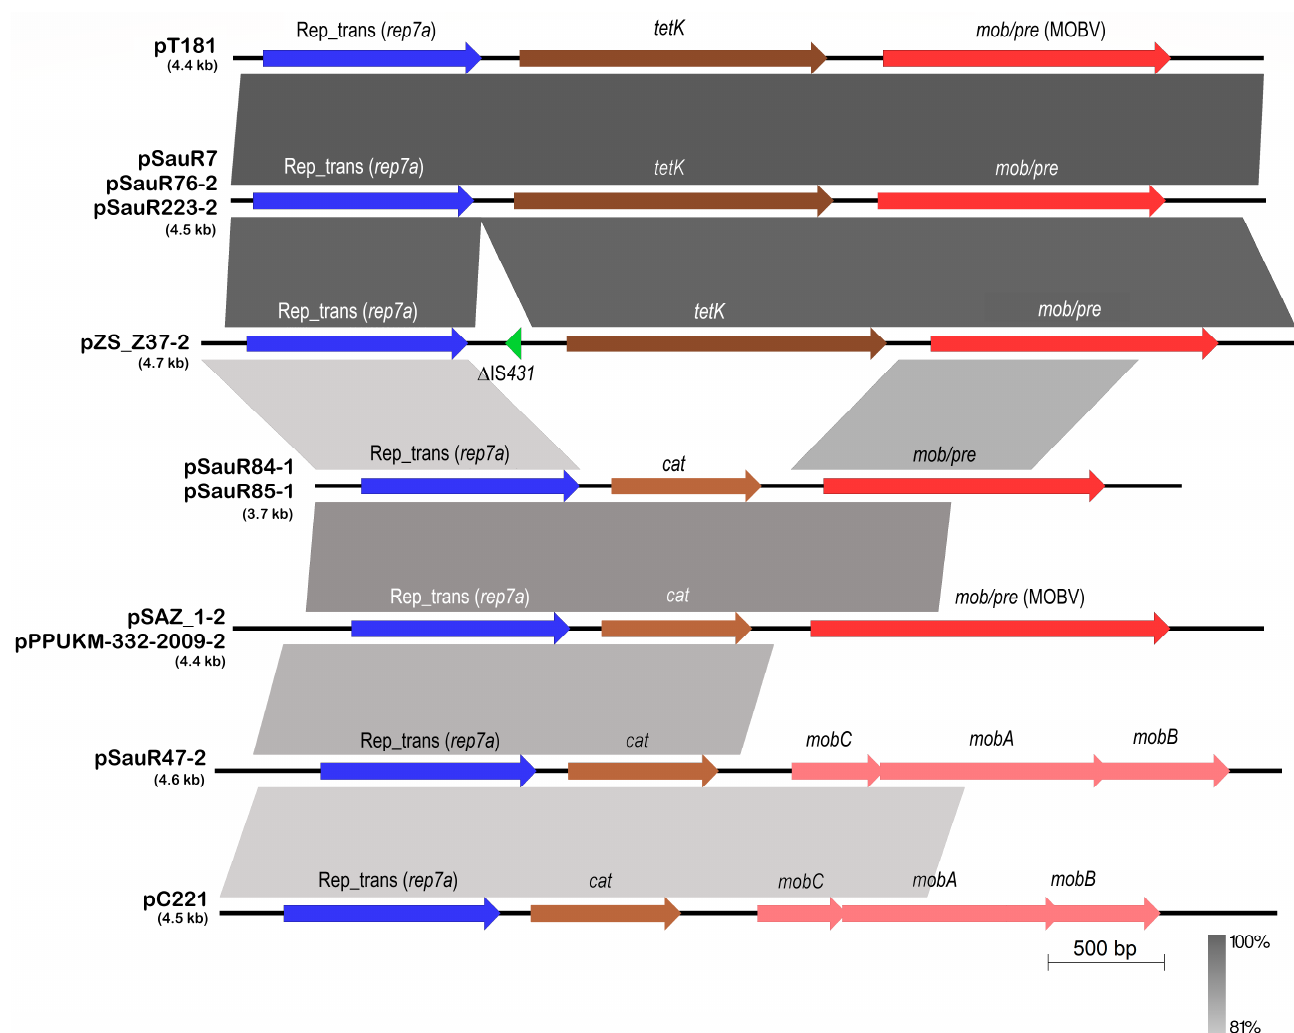
Figure 10. Comparative linear maps of the single-replicon Rep_trans plasmids identified in this study with the reference Rep_trans plasmids pT181 (accession no. NC_001393) and pC221 (accession no. X02166) of the pT181 family. Arrows show the extent and direction of genes and ORFs while regions with >81% nucleotide sequence identities are depicted as shaded grey areas with darker shades of grey indicating higher nucleotide sequence identities. The Rep_trans replicase genes are indicated as dark blue arrows while the tetK tetracycline resistance and the cat chloramphenicol resistance genes are depicted as brown arrows. Mobilization genes mob/pre of the MOBV family, and mobCAB of the MOBP family, are shown as red arrows. A truncated version of IS 431 is found in pZS_Z37-2, and this is shown as a green arrow and labeled “ ∆ IS 431